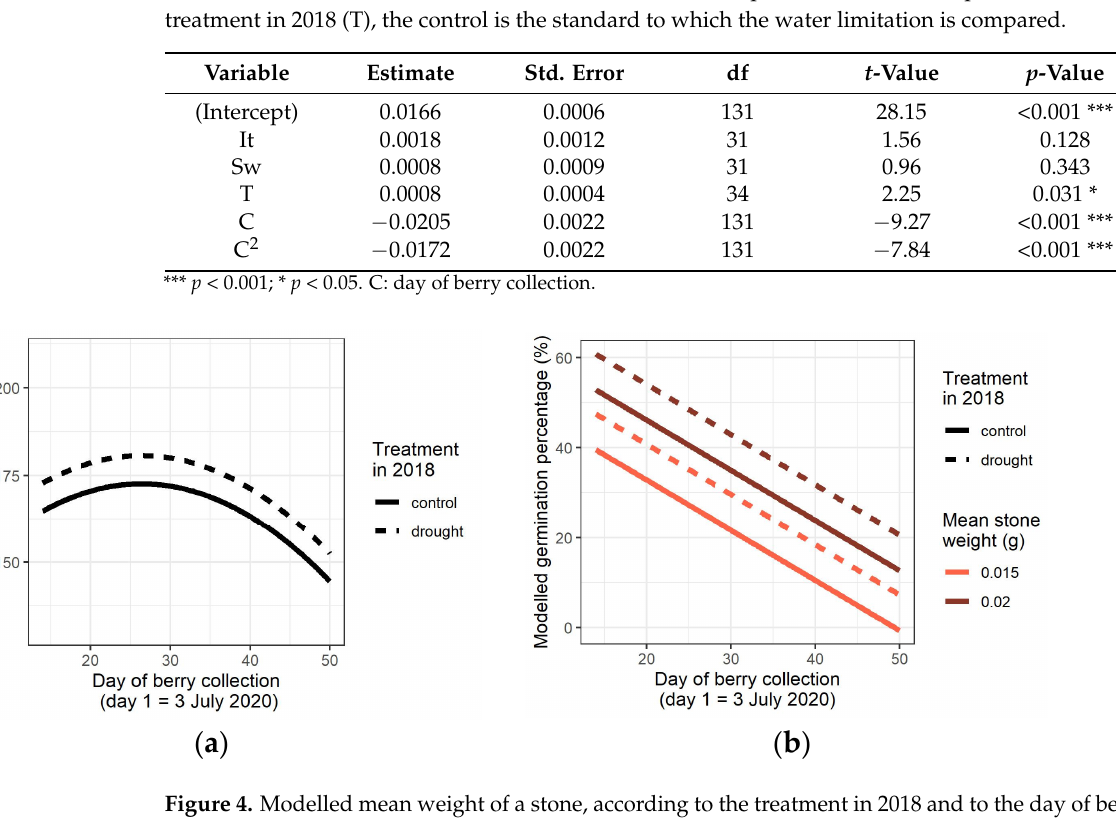
Table 5. Statistical analysis of the germination percentage and the timing of seedling emergence in the spring of 2021. In the model, the Belgian provenance is the standard to which the Italian (It) and Swedish (Sw) provenances are compared, and for the treatment in 2018 (T), the control is the stand- ard to which the water limitation is compared. Germination Percentage